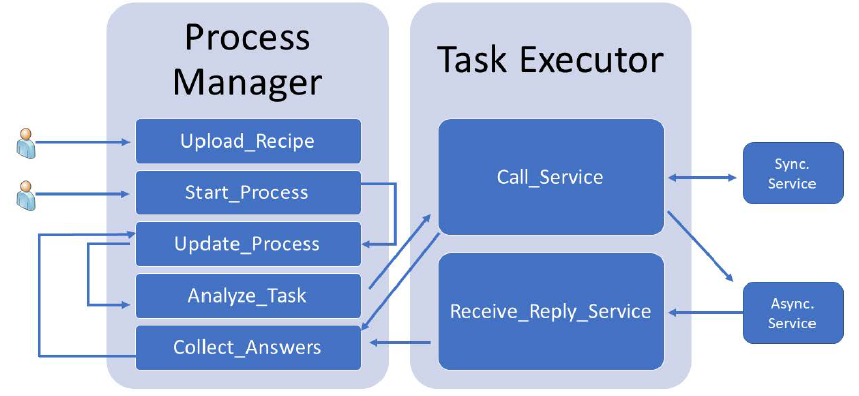
Figure 7. Node-RED Workflow Manager endpoints and modules